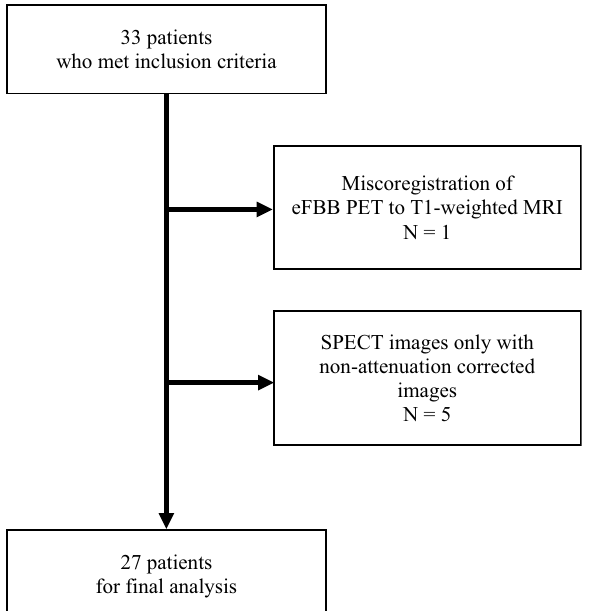
Figure 1. Flowchart for patient selection.